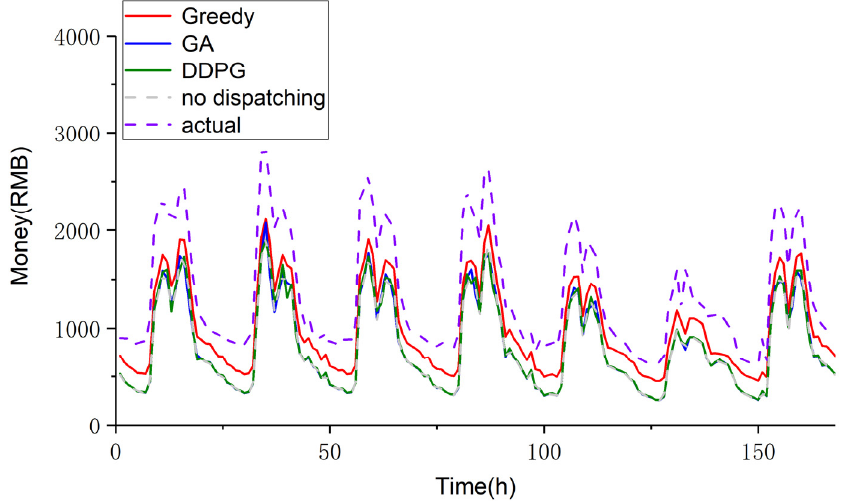
Figure 13. Change of money of energy management experiments .